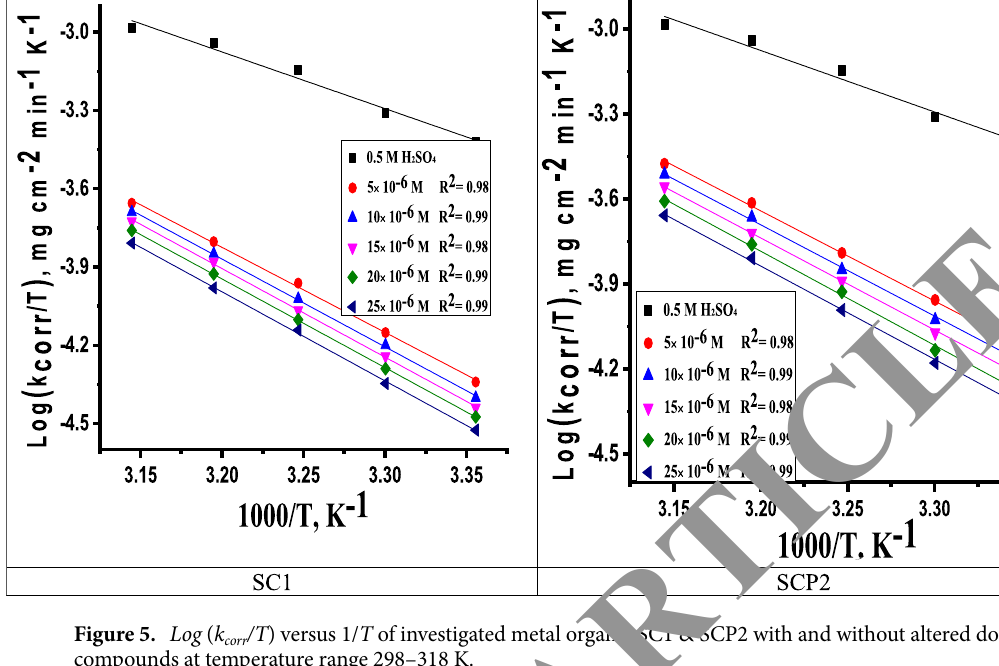
Figure 5. Log ( k corr /T ) versus 1/ T of investigated metal organic SC1 & SCP2 with and without altered doses of compounds at temperature range 298–318 K.